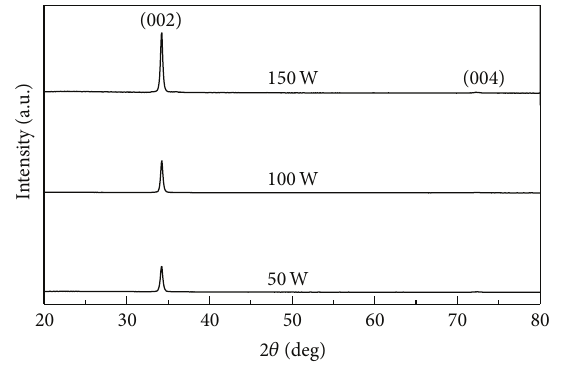
Figure 1: X-ray diffraction (XRD) patterns of the FZO thin films as a function of deposition power.